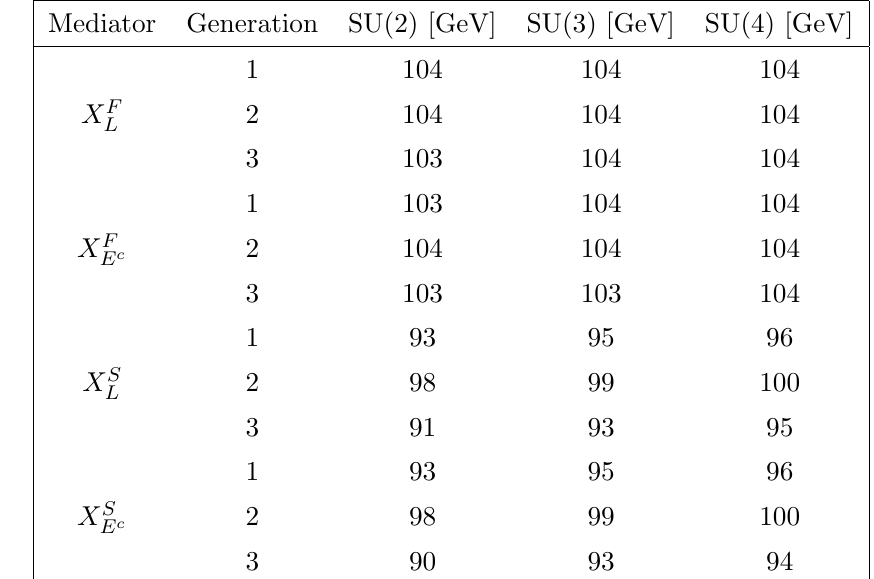
Table 1. Lower limit on the mass of mediators of category II at 95% CLs for r inv = 0. Generation corresponds to the single generation of leptons the mediator couples with. Bounds are given for G corresponding to di(cid:11)erent SU( N ) and originate from the LEP search of ref. [51] for leptoquarks.